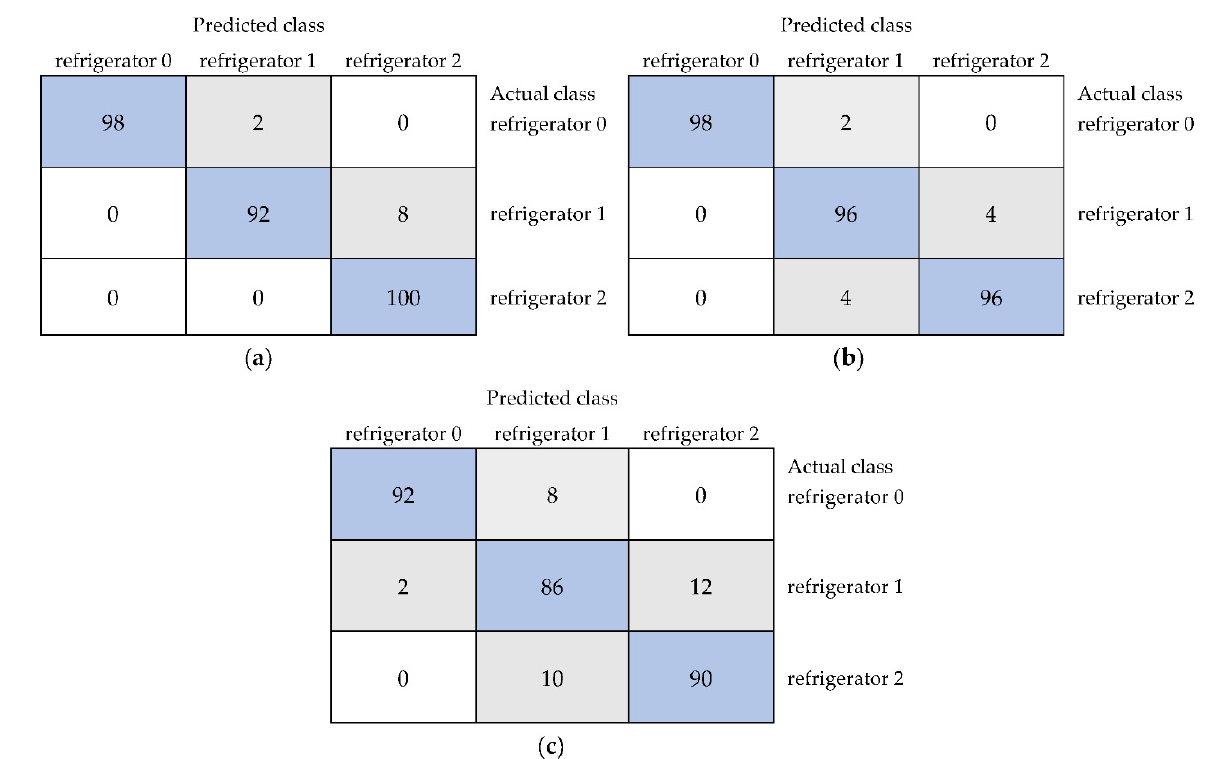
Figure 3. The confusion matrices of the classification of black currant samples, namely unstored (refrigerator 0) and stored in the refrigerator for 1 week (refrigerator 1) and 2 weeks (refrigerator 2), using selected image textures from color space RGB for the models built using the IBk ( a ), Bayes net, ( b ) and JRip algorithms ( c ).